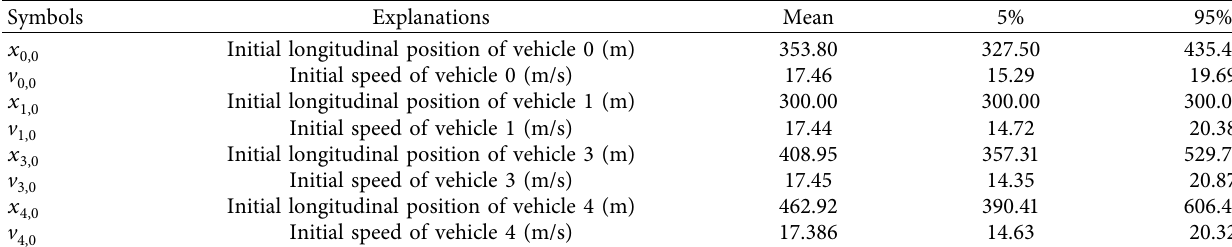
Table 1: Statistics of generated